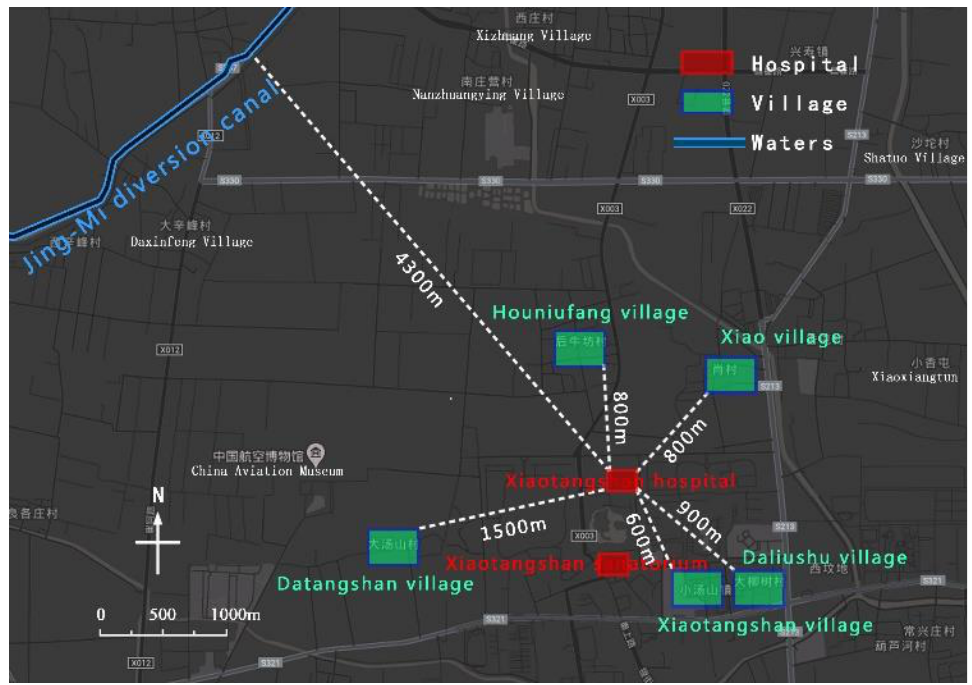
Figure 1. Site environment of Xiaotangshan hospital in 2003.